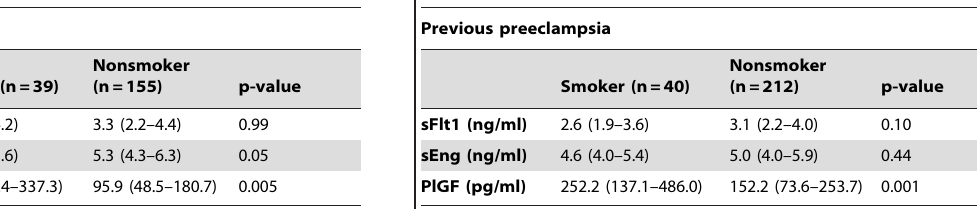
Table 2. Comparison of angiogenic factors in pregnant women with pregestational diabetes: smokers versus